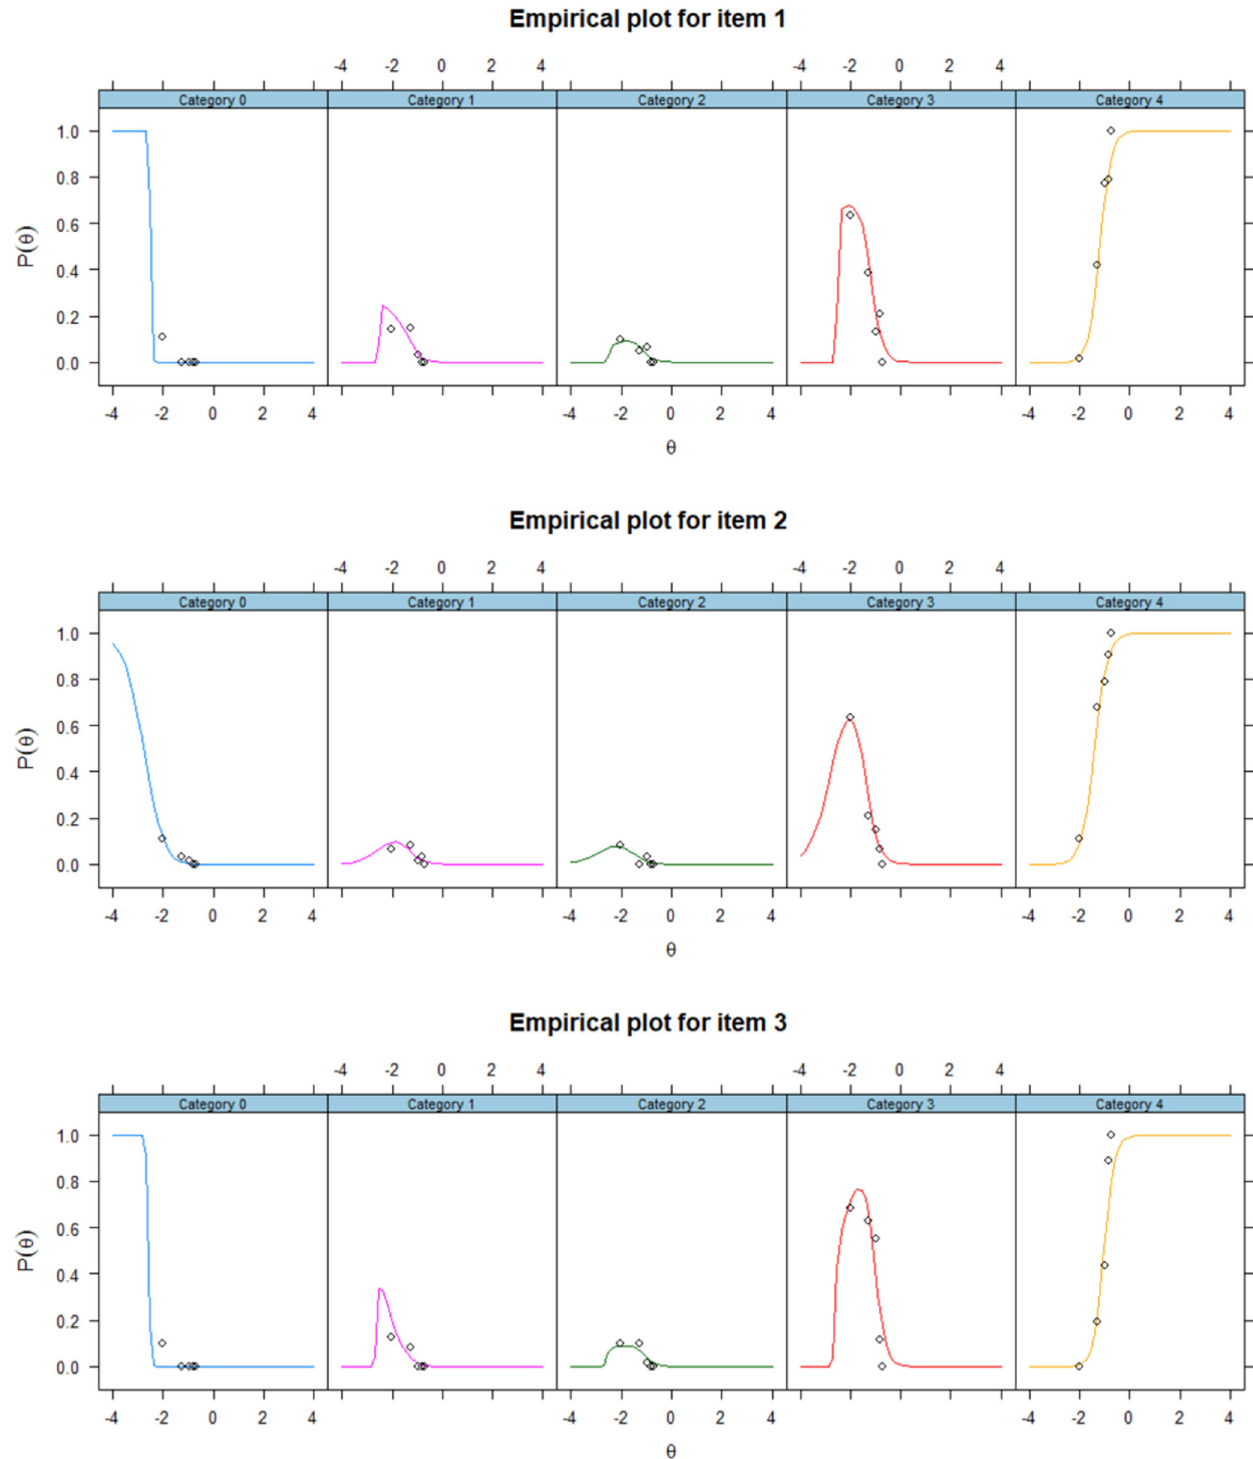
Fig. 4 Empirical plots of NRM. The observed data (the dots) and predicted values (the lines) from NRM for all items.The small gap between the observed and predicted values indicates a good model-data fi for each of the m i response categories. To identify the model, > a iq , thus response k indicates higher θ than response q. The the mean and variance of θ are fi xed to 0 and 1, respectively. intercept parameter, c ik re fl ect the relative frequency of Within each item, the order for the response categories with selecting category k, where larger c ik re fl ects relatively higher respect to the latent trait is determined by the value of a ik , a frequency for category k. After fi tting the NRM using Eq. 3, item larger value of a ik indicates a higher level of θ . For example, if a ik parameters and person ’ s latent trait could be estimated 66 . The